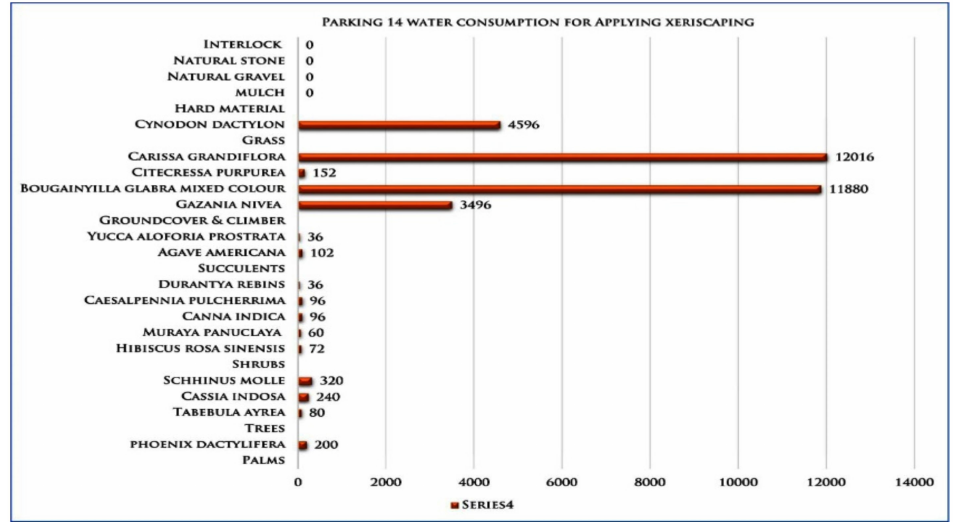
Figure 14. Experiment 1 water consumption quantity after applying for xeriscaping status. Xeriscap- ing softscape design water consumption (Details in Table